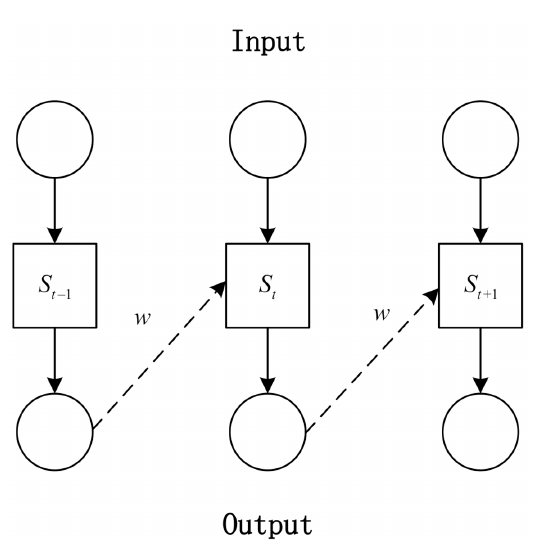
Figure 3. The structure of RNN.